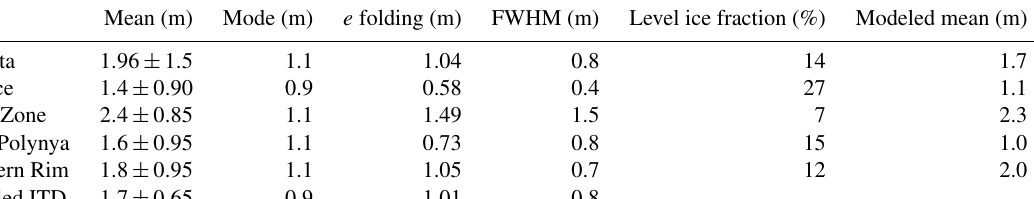
Table 1. Properties of ITDs of different zones of the refrozen polynya and the result of the simple, volume-conserving thickness model (see Sect. 3.3). Mean thickness is shown with standard deviation.